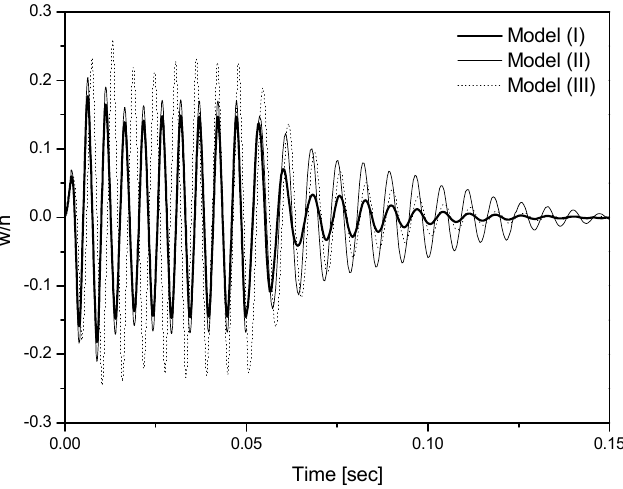
Figure 11. The flutter suppression of the designed models ( λ = 1200, ∆ T = 30 ).